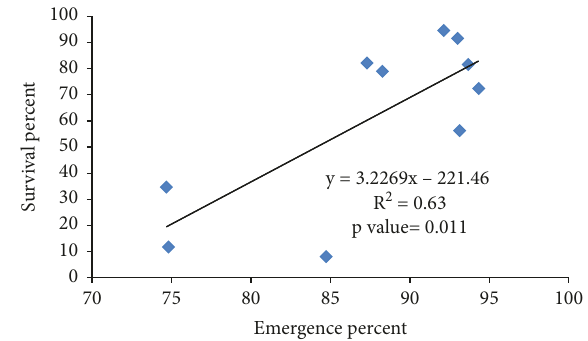
Figure 1: The relationship between survival percent and emergence percent of tobacco